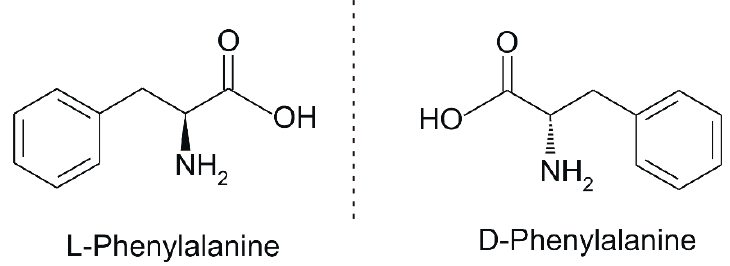
Figure 1. Chemical structures of Phe stereoisomers.